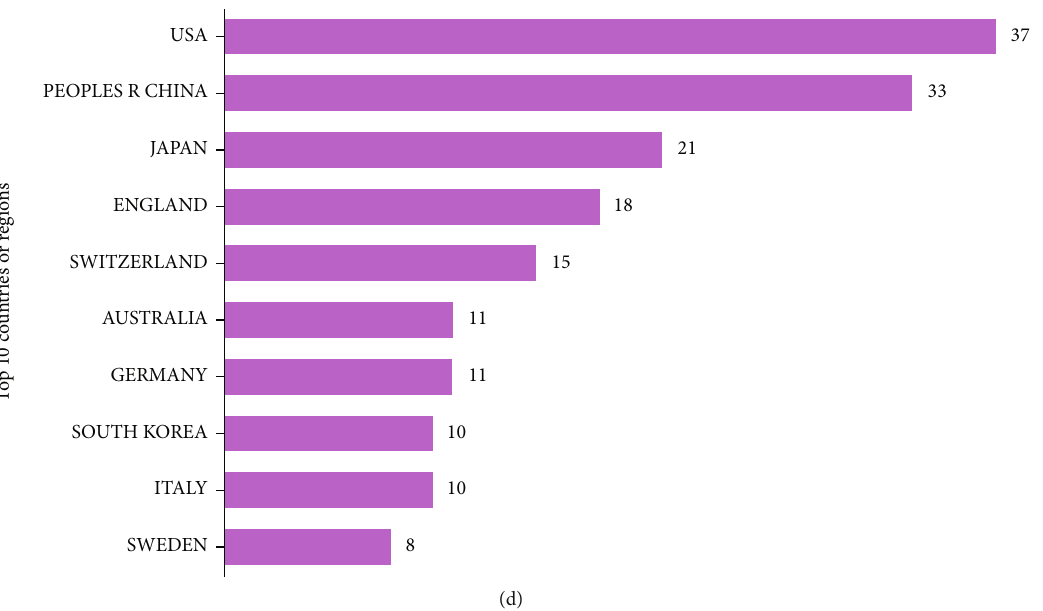
Figure 2: (a) Contribution of all countries by Publications. (b – d) Total number of publications, sum of total citations, and H-index of top 10 countries on stem and progenitor cells in intervertebral